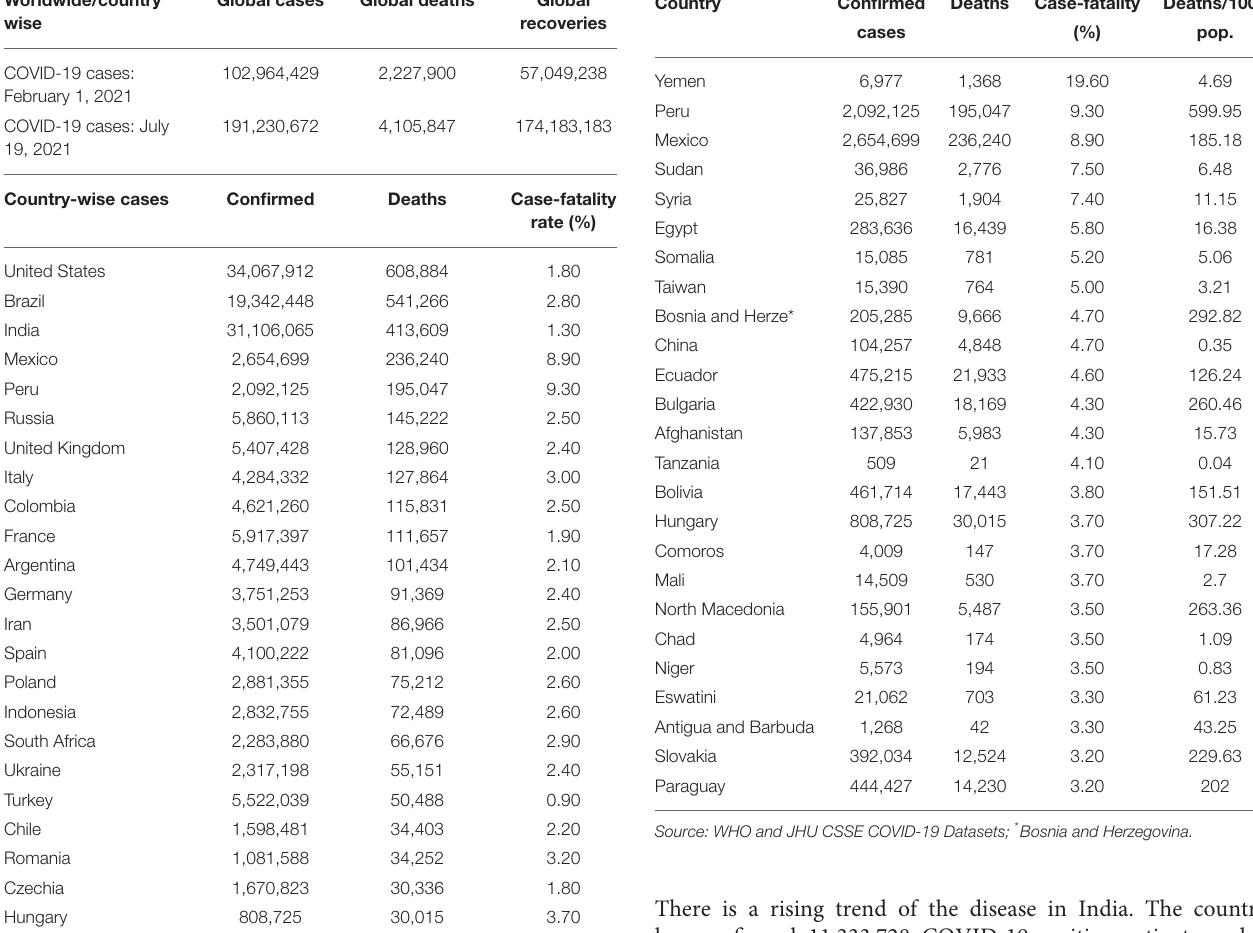
TABLE 3 | COVID-19 cases and mortality of the most affected countries, as of July 18, 2021. Country Confirmed recoveries